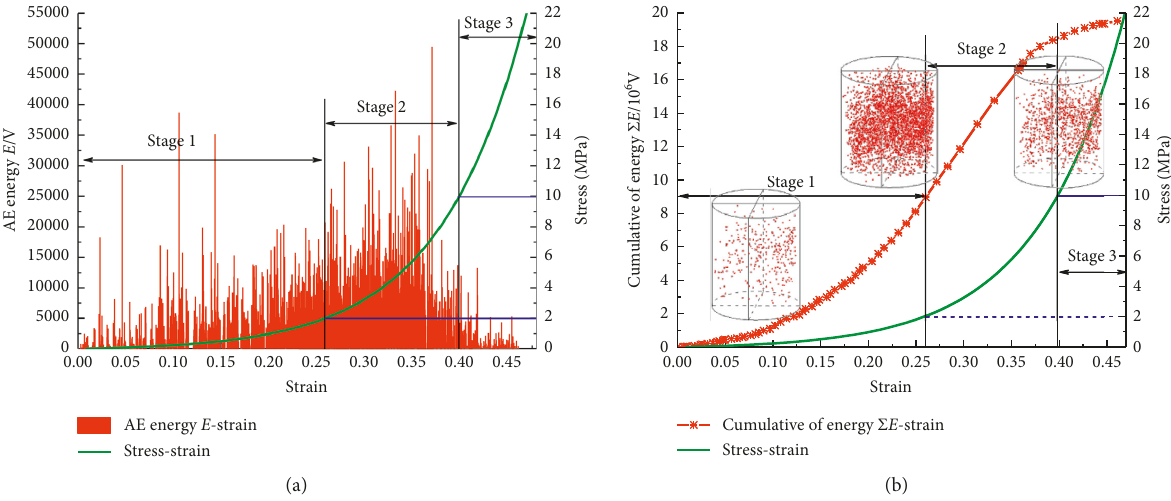
Figure 5: Variations in AE energy and cumulative energy with strain on stress-strain curve. (a) AE energy. (b) Cumulative energy.